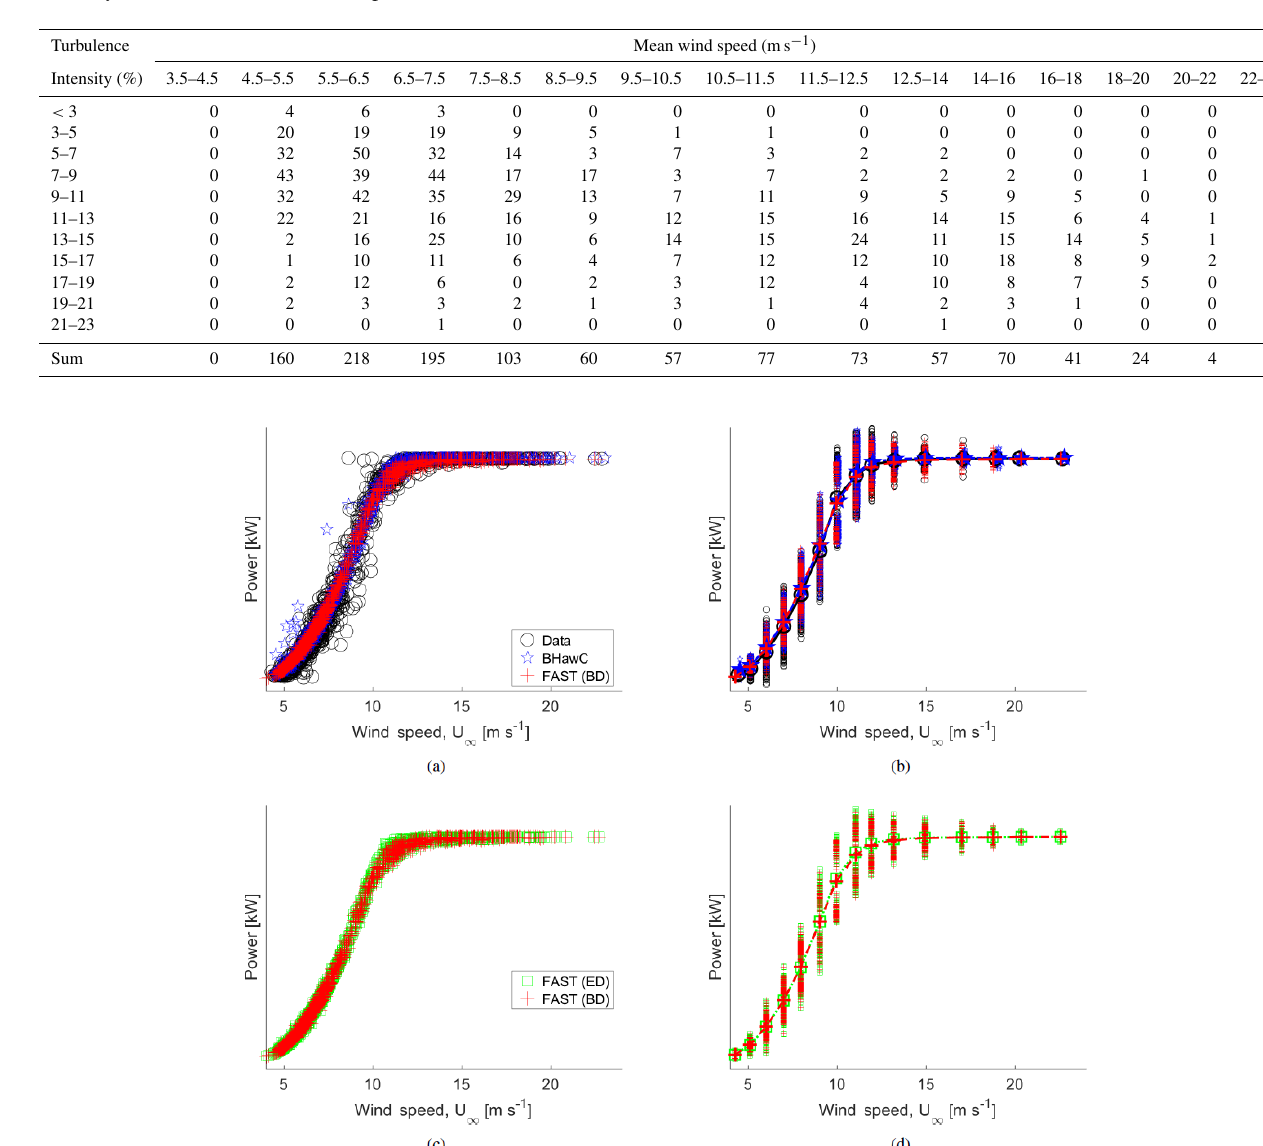
Figure 1. Electrical power. (a) Individual 10min averages from experimental data, BHawC, and FAST (BD). (b) Binned averages of data in (a) are denoted by points connected by lines; the scatter above and below these data denotes plus or minus 1 standard deviation, respectively, of the individual 10min data sets in that bin. (c) Individual 10min averages from FAST (BD) and FAST (ED). (d) Binned averages of data in (c) are denoted by the points connected by lines; the scatter above and below these data denotes plus or minus 1 standard deviation, respectively, of the individual 10 min data sets in that